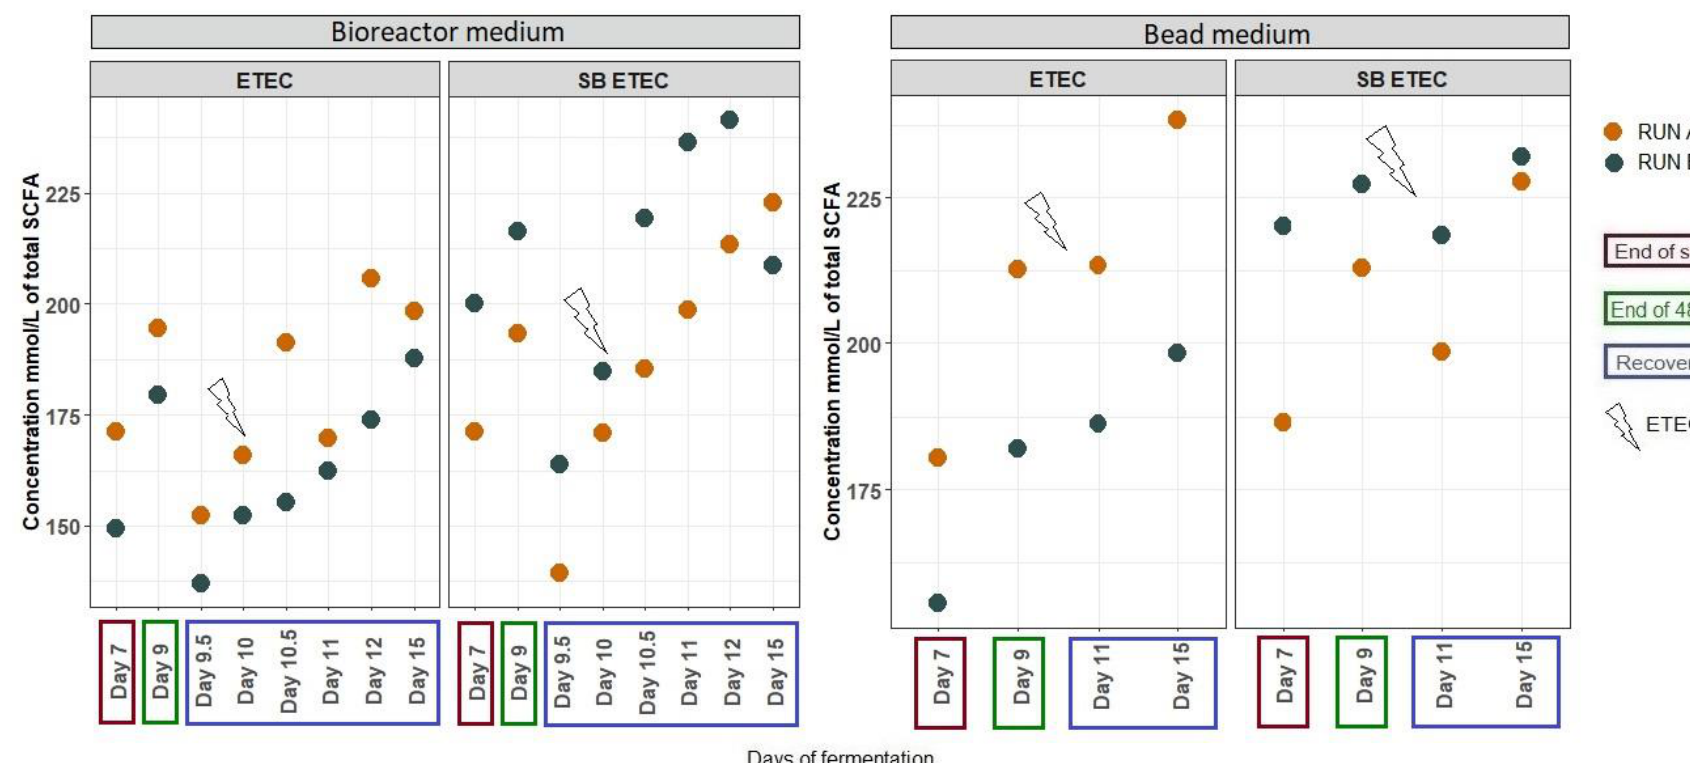
Figure 4. Total SCFA concentration in the MPigut-IVM during ETEC and SBETEC conditions. Each value is an average of two technical replicates.